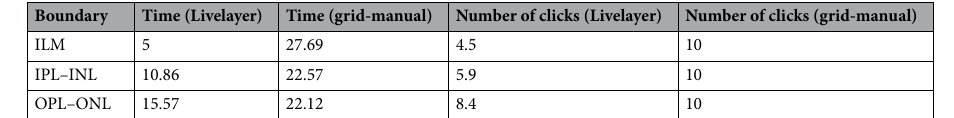
Table 2. A comparison between the required amount of time (in seconds) and the number of clicks for Livelayer and grid-manual.